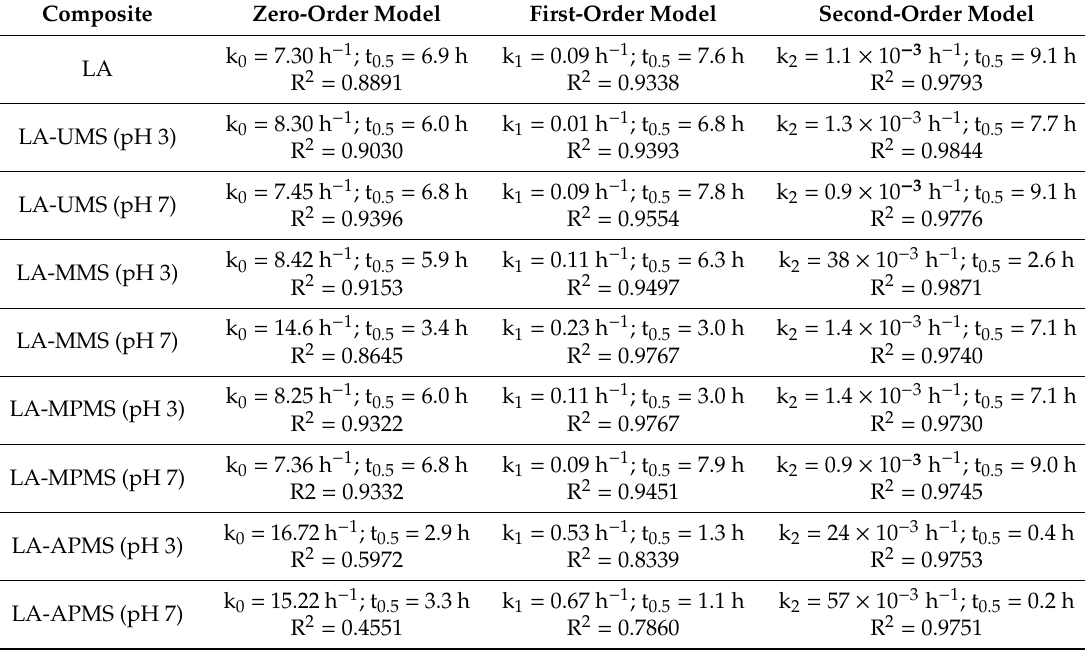
Table 4. Kinetic parameters of photodegradation of free LA and LA in the synthesized composites. Composite Zero-Order Model First-Order Model Second-Order Model